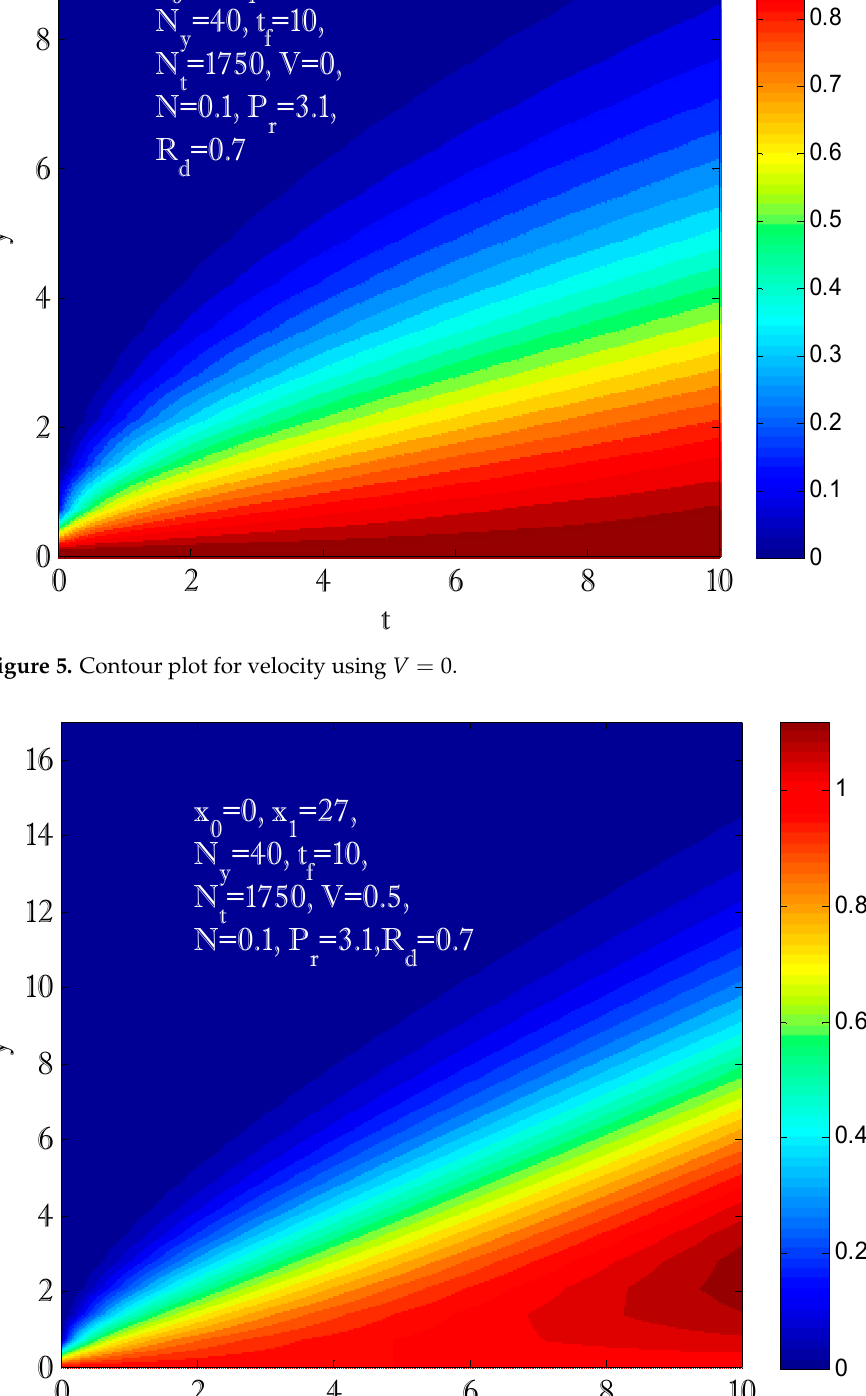
Figure 6. Contour plot for velocity using V = 0.5.